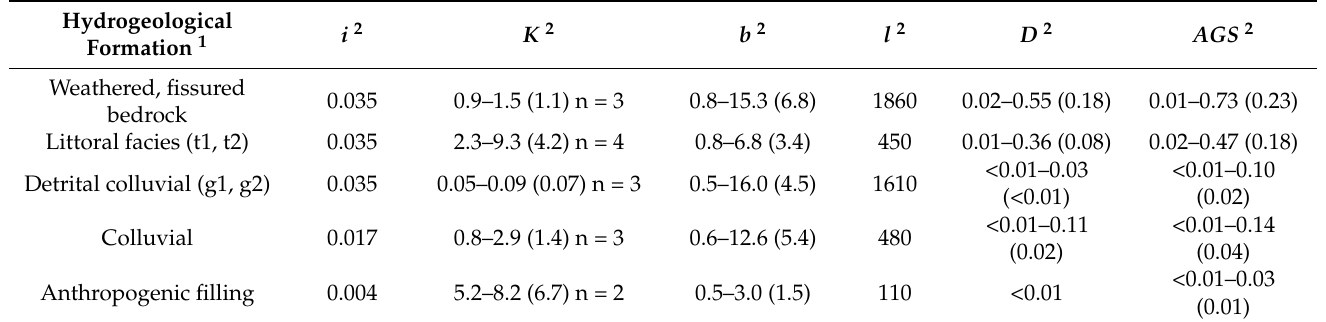
Table 3. NSUS groundwater discharge after the Darcy’s Law formulation.